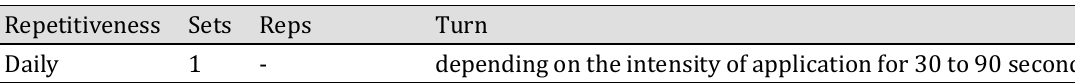
Table 1. Containment stage technique